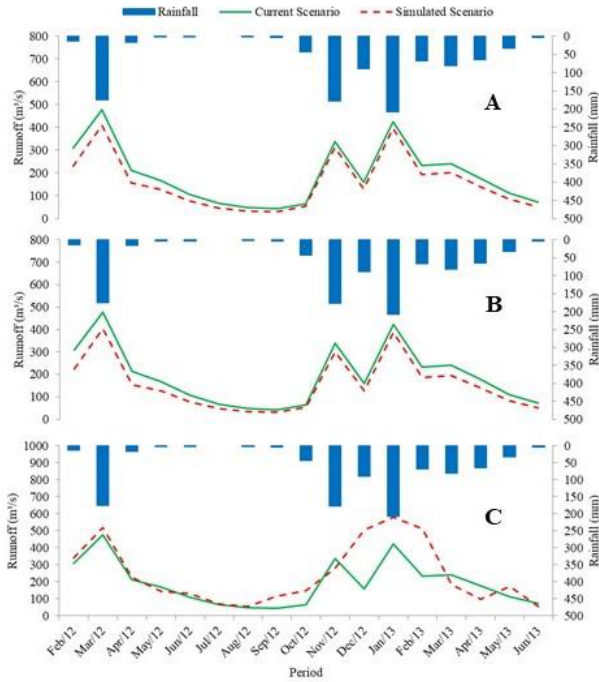
Figure 6 – Flow behavior for Scenarios I (A), II (B) and III (C) compared to the flows of the Current